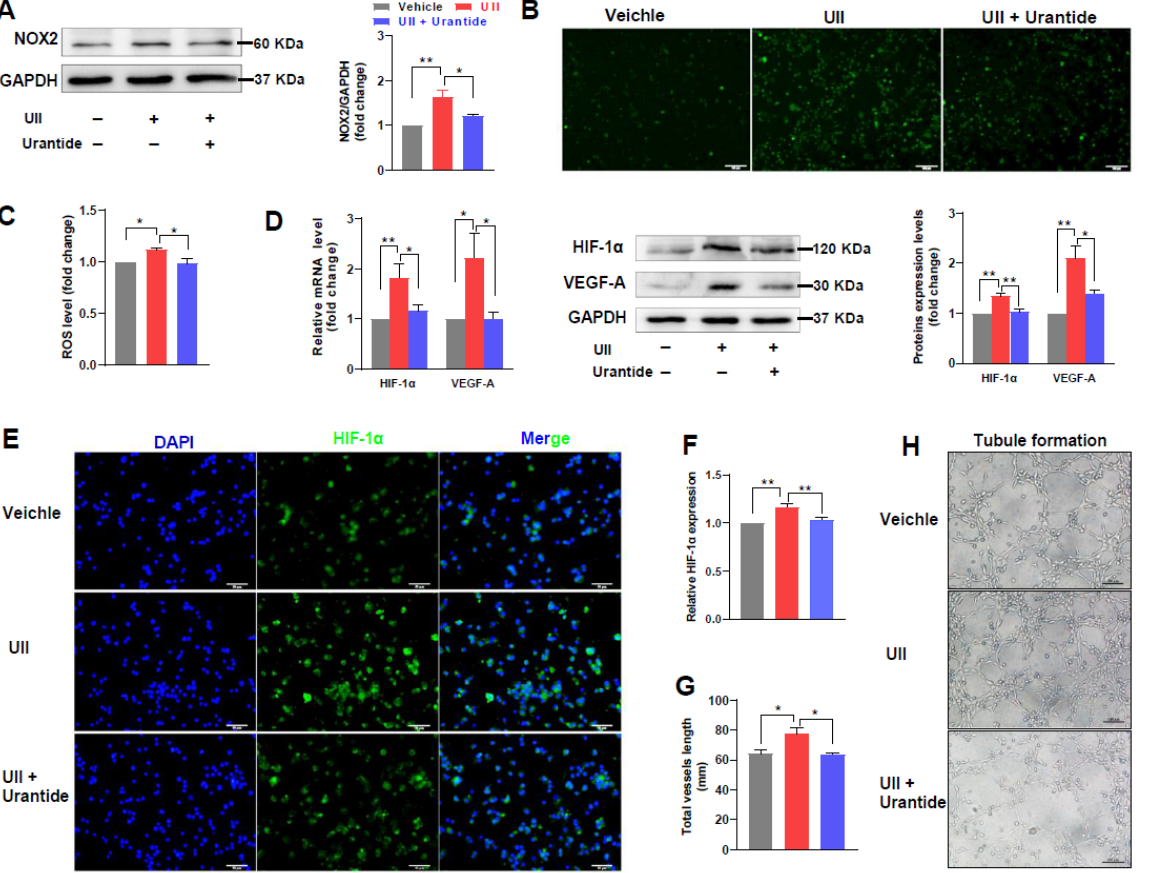
Figure 6. Determination of UII effects on the cultured cells. ( A ) NOX2 expression after being treated with 100 nM UII with or without urantide for 24 h in cultured macrophages. ( B , C ) ROS synthesis in macrophages was determined by the detection of the DCFH-DA fluorescent intensity. Representative images were shown in ( B ) and fluorescent intensity was quantified and shown in ( C ). Scale bar, 100 µ m. ( D ) qRT-PCR (left) and WB (right) analyses of HIF-1 α /VEGF-A expression in macrophages after UII with or without urantide treatment for 24 h. UII treatment significantly increased the expression of these two genes but was inhibited by the presence of urantide. Western blotting confirmed that UII upregulated HIF-1 α /VEGF-A expression and this upregulation could be partly blocked by urantide. ( E ) and ( F ) HIF-1 α expression in macrophages was detected by fluorescence microscopy and green fluorescence was used to label HIF-1 α , scale bar, 50 µ m ( E ). UII upregulated HIF-1 α expression and could be partially blocked by urantide. Quantification of the relative intensity of HIF-1 α fluorescence ( F ). ( G ) and ( H ) UII stimulated angiogenesis in Matrigel with seeded HUVECs after 4 h of culture. Quantification of tubule formation, scale bar, 100 µ m. Data are shown as mean ± SEM (three to five biological repeats). * p < 0.05, ** p < 0.01 vs. vehicle